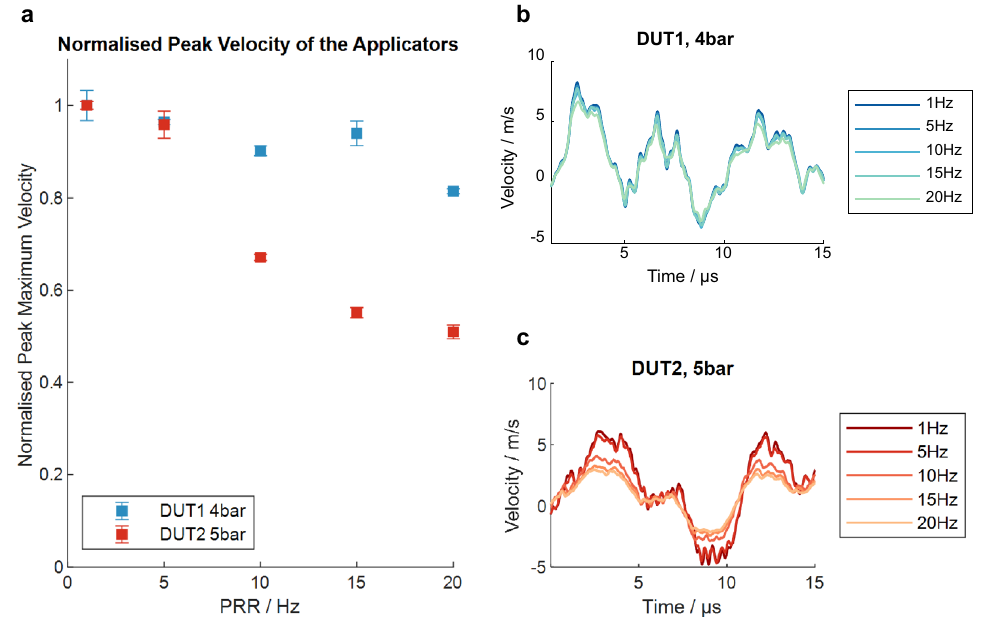
Figure 5. Vibrometer measurements. ( a ) Normalised peak maximum velocity measured for DUT1 and DUT2 at different pulse repetition rates and maximum pressure level. Mean velocity curves measured for DUT1 ( b ) and DUT2 ( c ) at different pulse repetition rates and maximum pressure